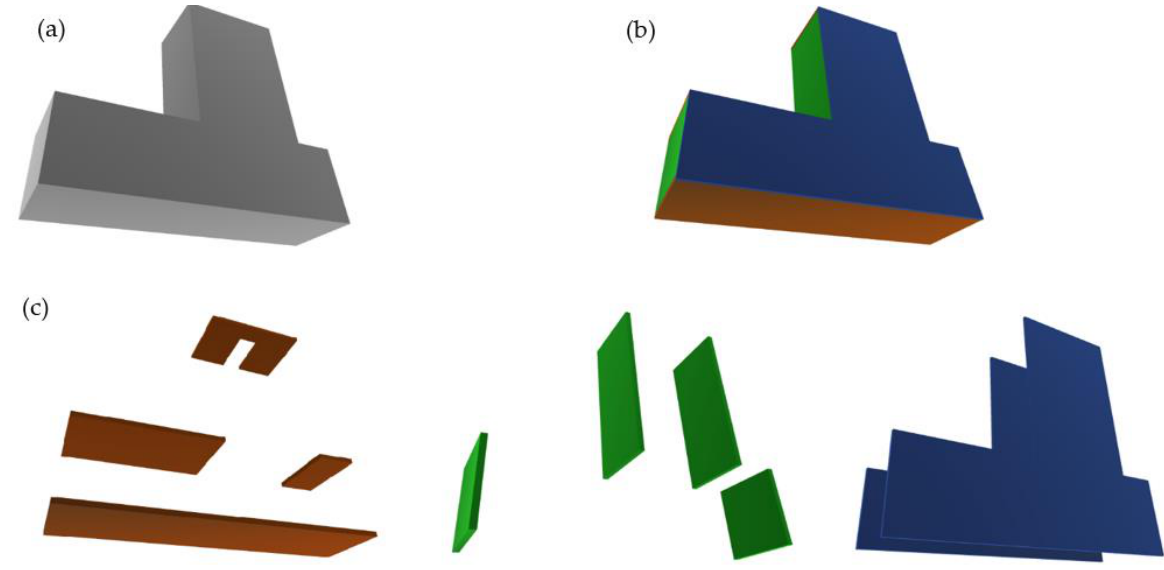
Figure 3. Visual representation of ( a ) model, ( b ) segmented planar components, and ( c ) planar segments grouped into clusters .